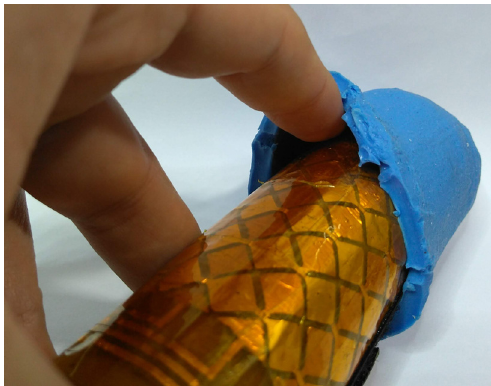
Figure 21: The touch - sensitive interface can be installed beneath the silicone sleeve of the sex toys and continue to detect the touch.